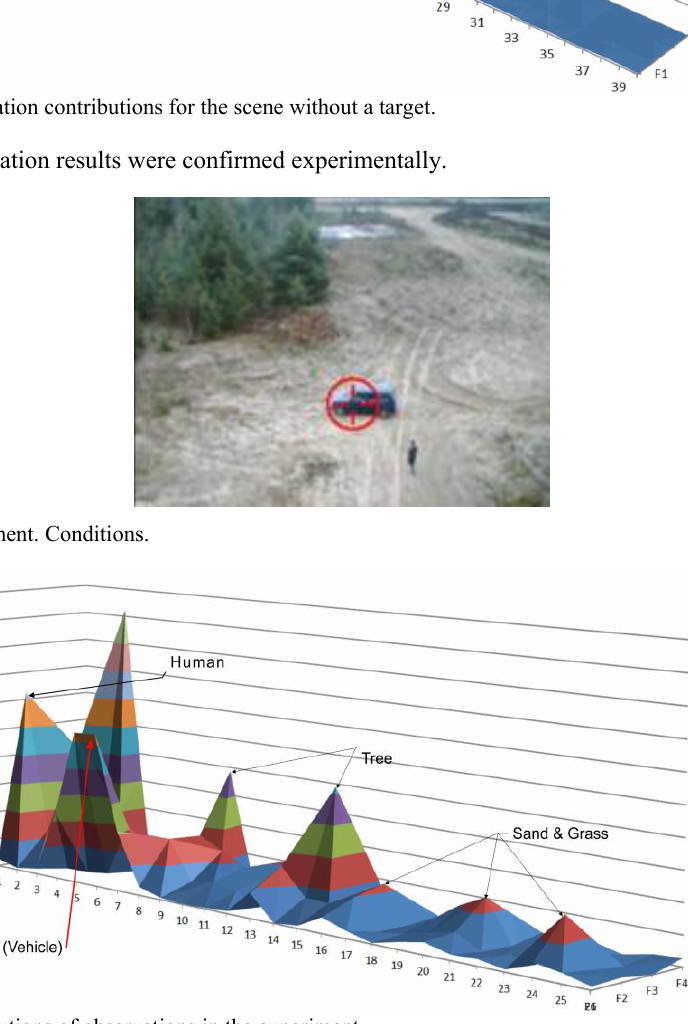
Fig. 6. Contributions of observations in the